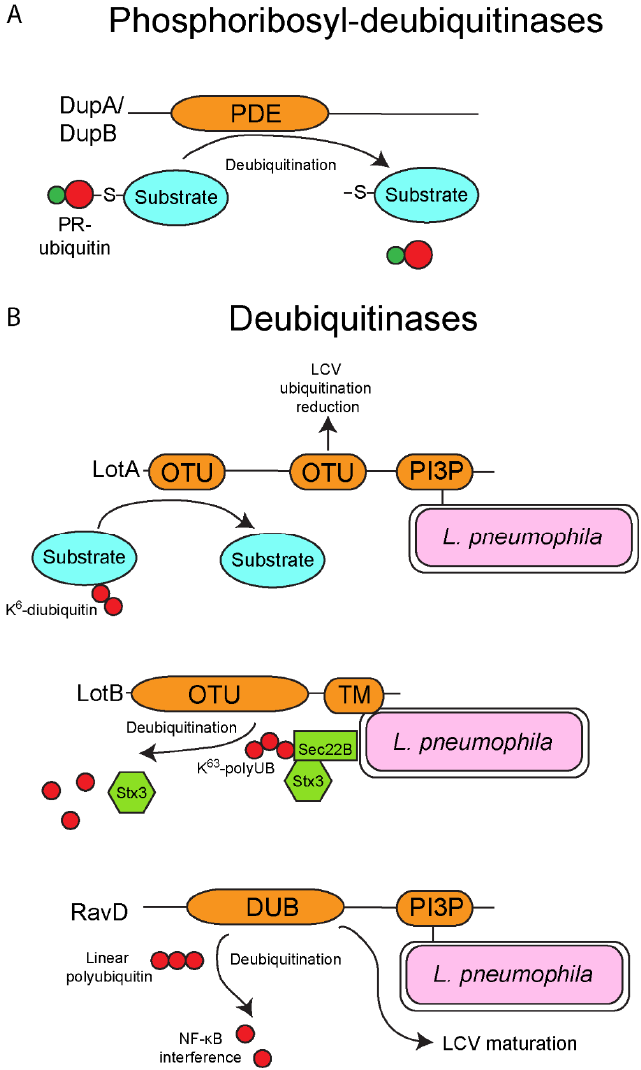
Figure 3. Deubiquitinases of L. pneumophila . Besides possessing several ubiquitin ligase, L. pneu- mophila also injects into the cytosol of host cells several deubiquitinases. ( A ) Phosphoribosyl- deubiquitinases of L. pneumophila . The SidE family-dependent phosphoribosyl-ubiquitination of proteins can be reversed by the deubiquitinase activity of the two injected effectors, DupA and DupB. Both DupA and DupB possess a PDE domain homologous to those found in the SidE family, but in contrast these domains catalyze the removal of phosphoribosyl-ubiquitin moieties from substrate proteins. ( B ) Deubiquitinases of L. pneumophila . L. pneumophila also possesses several deubiquitinases that specifically remove ubiquitin moieties from targeted proteins. LotA harbors two OTU domains and is localized to the LCV outer leaflet via its C-terminal PI3P-binding domain. LotA has been shown to reduce the overall ubiquitination of the LCV, and additionally specifically deubiquitinate proteins that are modified with a K 6 -diubiquitin moiety, though the functional importance of this effector is unknown. Similar to LotA, LotB also harbors an OTU domain and has a C-terminal transmembrane domain to allow localization to the LCV membrane. LotB specifically deubiquitinates K 63 -linked polyubiquitin chains from the host SNARE, Sec22B, resulting in the release of SNARE, Stx3. Finally, RavD harbors a deubiquitinase domain that specifically deubiquitinates linear polyubiquitin chains, and this may disrupt NF- κ B signaling. Similar to LotA, RavD has the C-terminal PI3P-binding domain to allow localization of the effector of the LCV